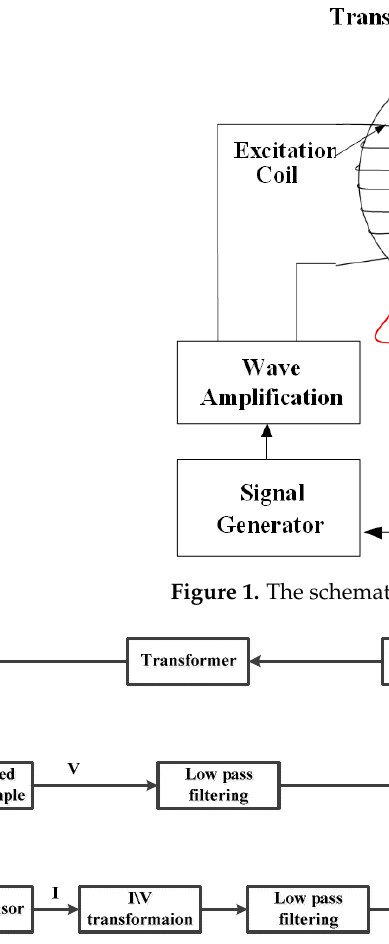
Figure 2. The hardware circuit structure diagram of NCACII.